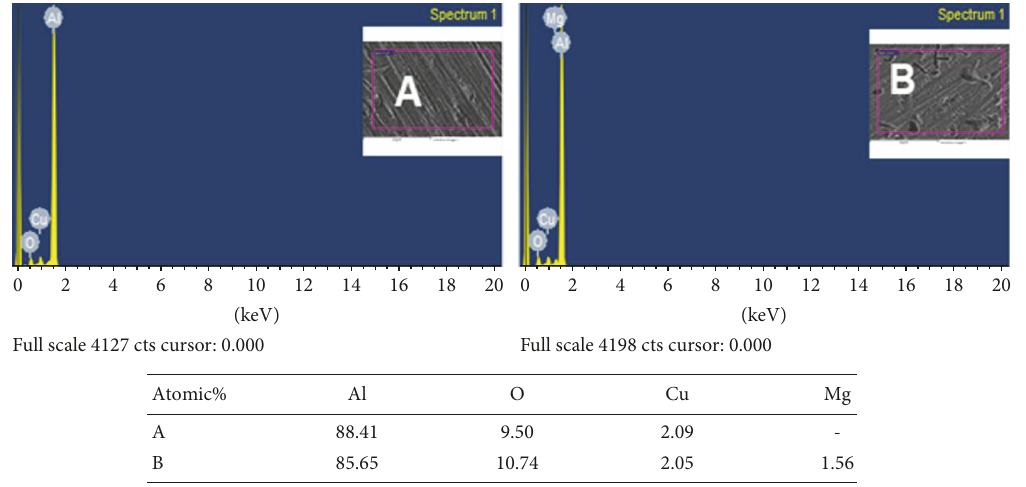
Figure 15: EDS results of Al 2024 “A” before and “B” after being immersed in the Red Sea water for 5 weeks.